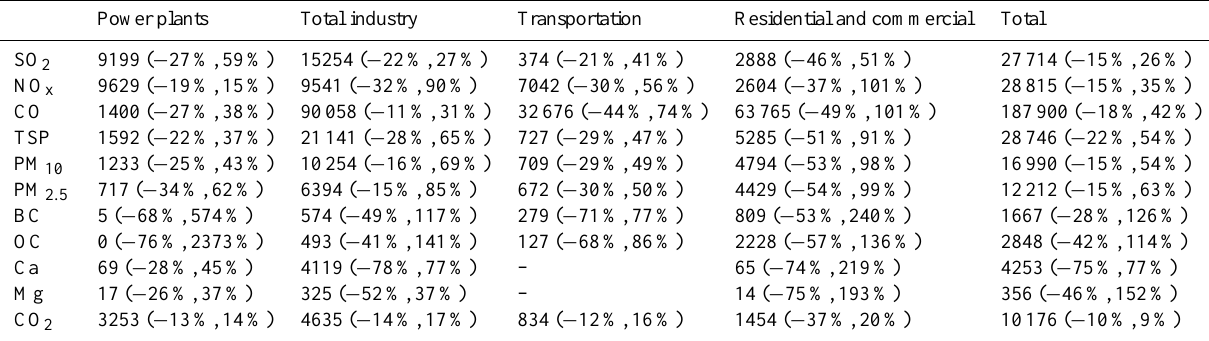
Table 2. Uncertainties of Chinese emissions by sector in 2010. The emissions are expressed as Mt for CO 2 and kt for other species. The percentages in the parentheses indicate the 95% CI around the central estimate.